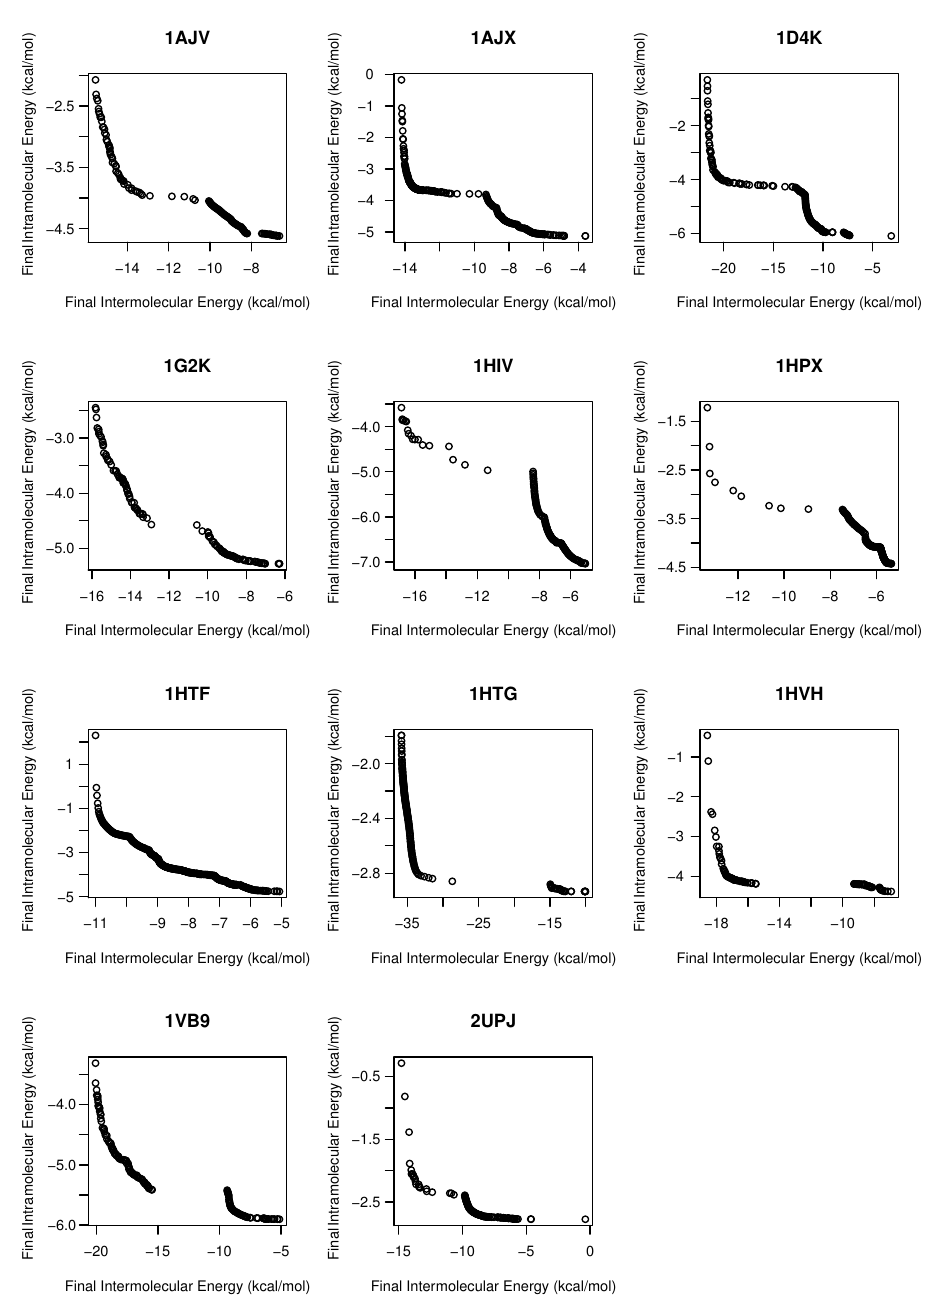
Figure 12. Reference fronts of non-dominated solutions computed from all